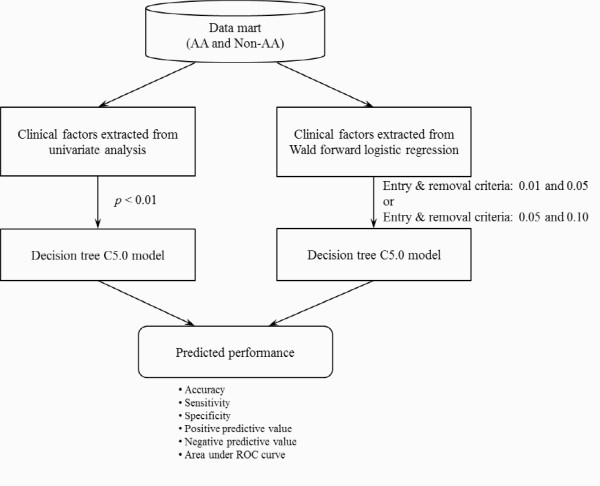
Scheme of the decision support models.